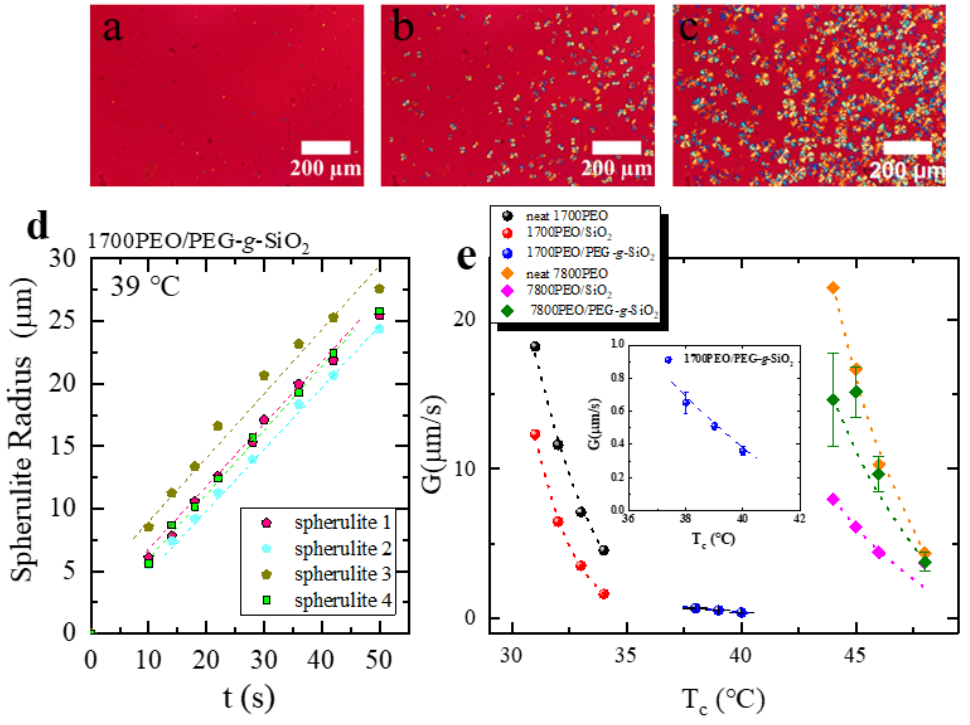
Figure 3. ( a – c ) PLOM images of 1700PEO/PEG-g-SiO 2 isothermally crystallized at 39 °C taken at 18 s, 30 s, and 74 s, respectively. ( d ) The variations of spherulitic radius with a function of time for four selected spherulites. ( e ) Spherulitic growth rate, G, as a function of temperature for each of the indicated PEO nanocomposites. The dotted lines correspond to the Lauritzen–Hoffman fits. The insert is the enlarged image of 1700PEO/PEG-g-SiO 2 .